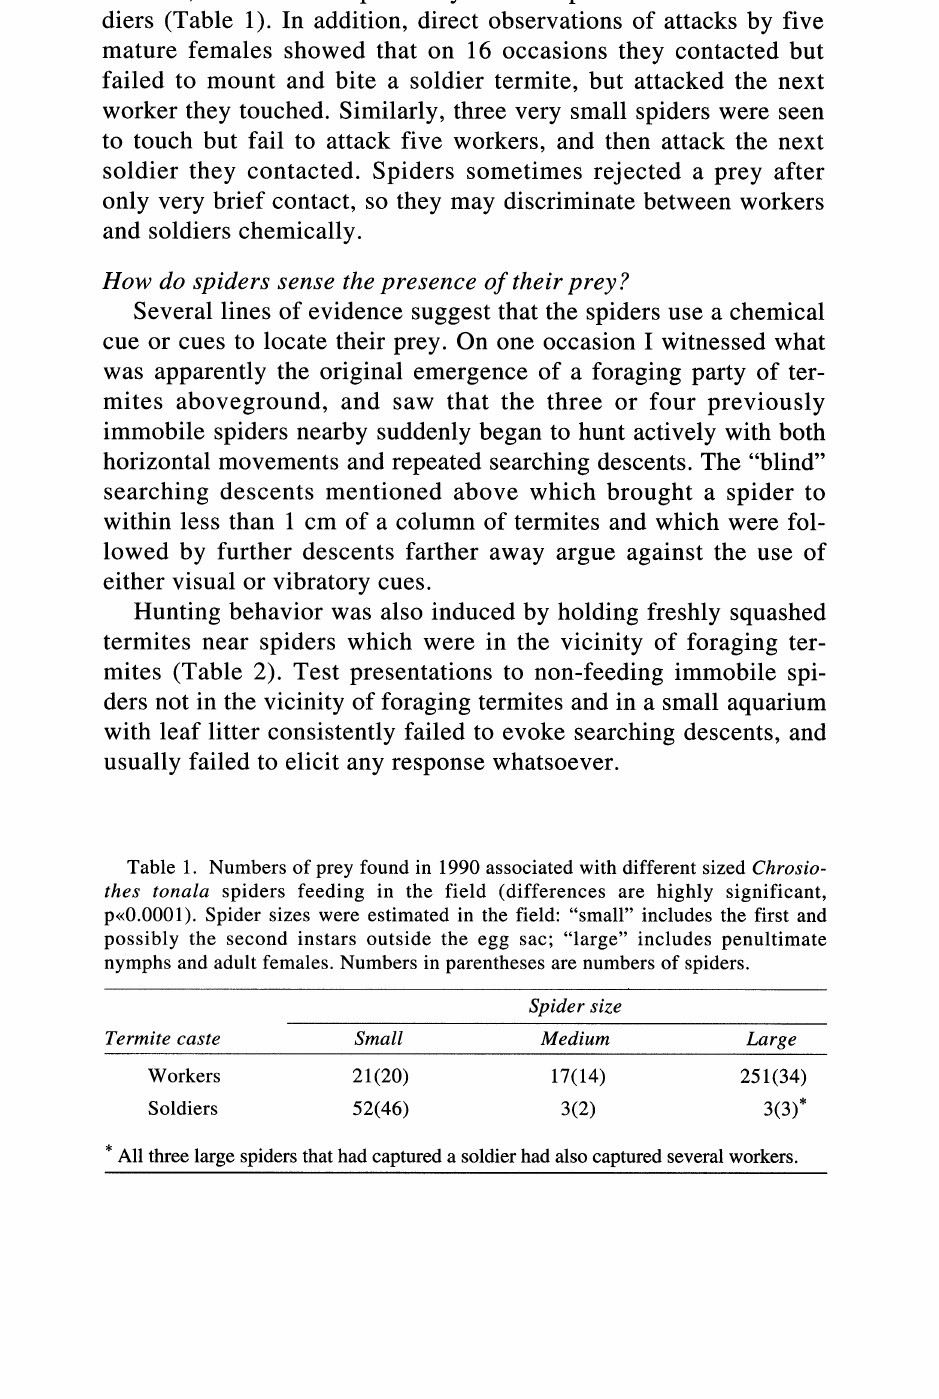
All three large spiders that had captured a soldier had also captured several